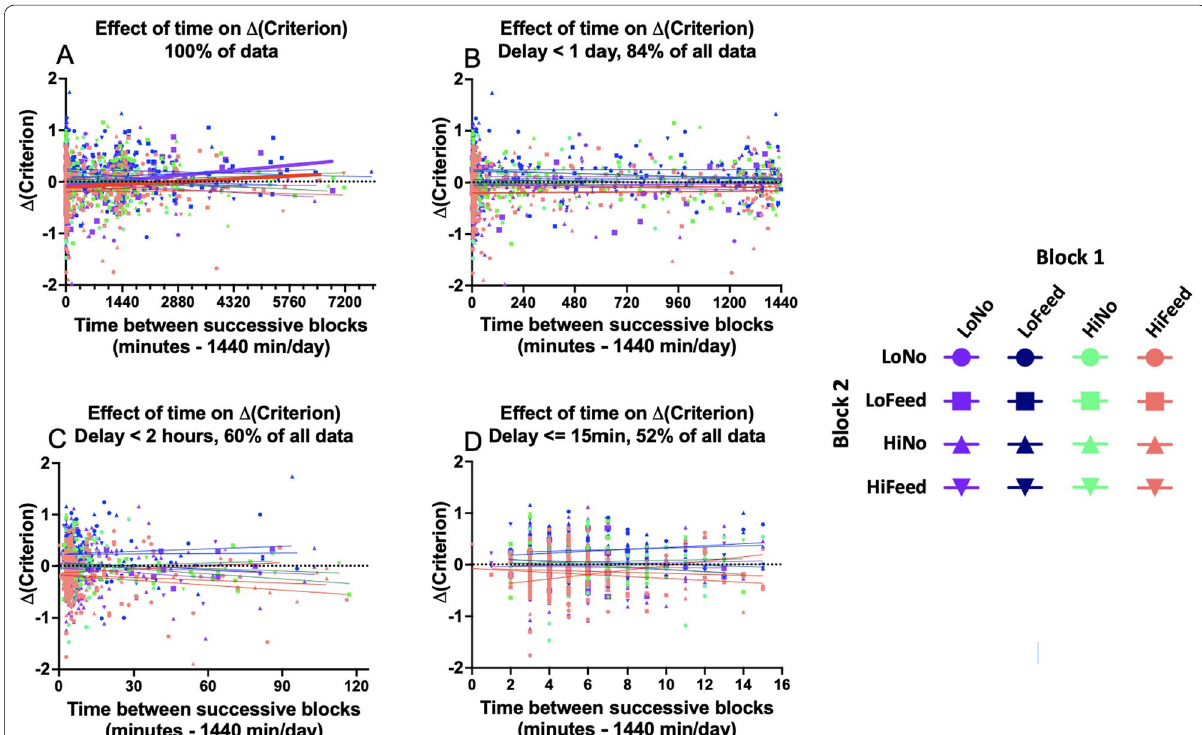
Fig. 6 Change in criterion as a function of time between the start of block 1 and start of block 2. 1440 min regressions for each of 16 pairs of block types. A All data, B Delay < 1 day, C Delay < 2 h, D Delay < 15 min. Repeat pairs (e.g., Low